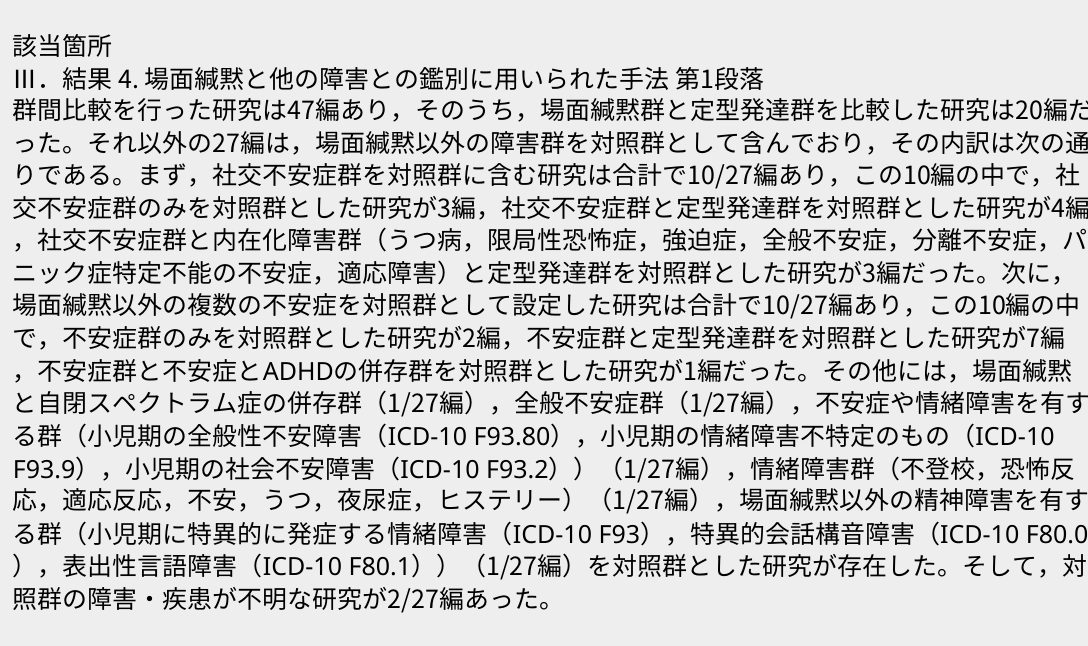
・Table1での ICD-9 の記述に関して Table1 の注に記載しました。